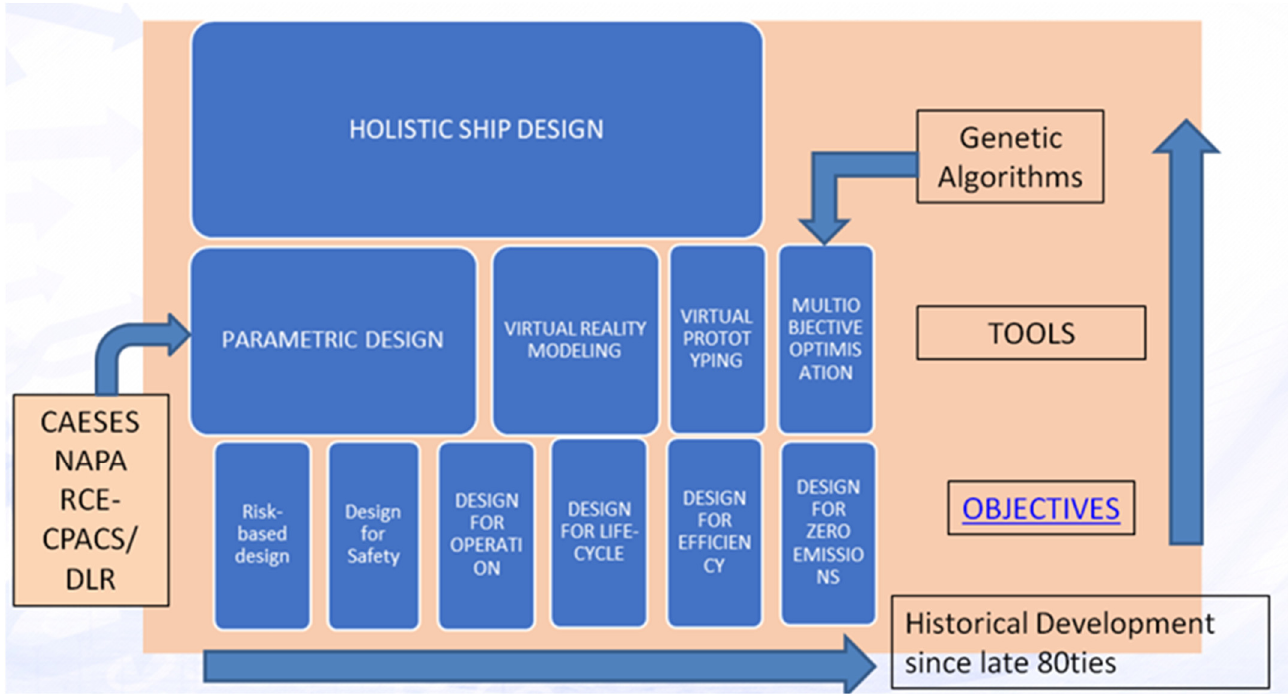
Figure 1. Evolution of Holistic Approach to Ship Design: Bottom-Up Systemic Approach.